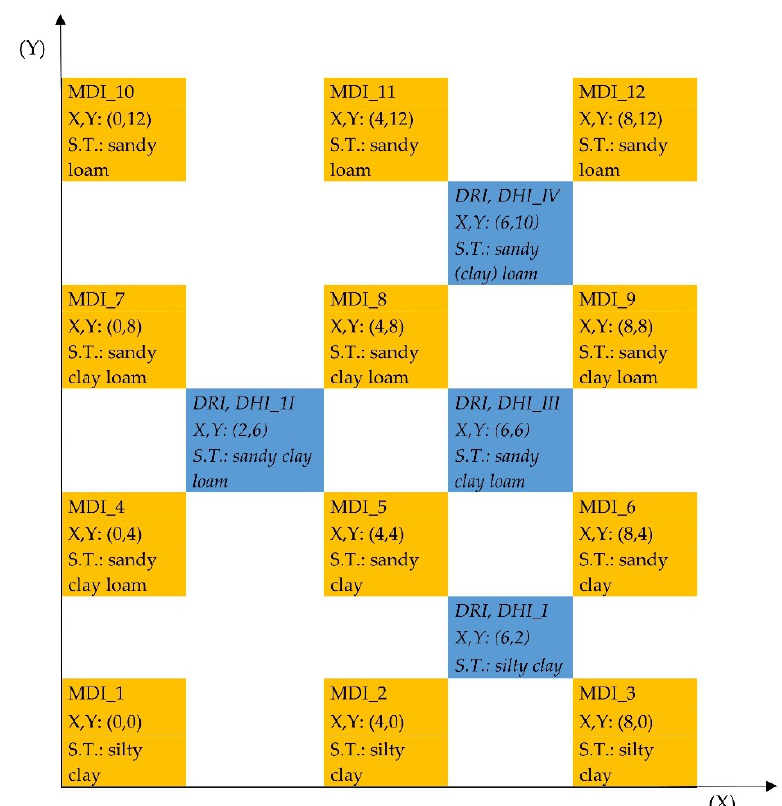
Figure 4. Soil texture (S.T.) at measurement locations.